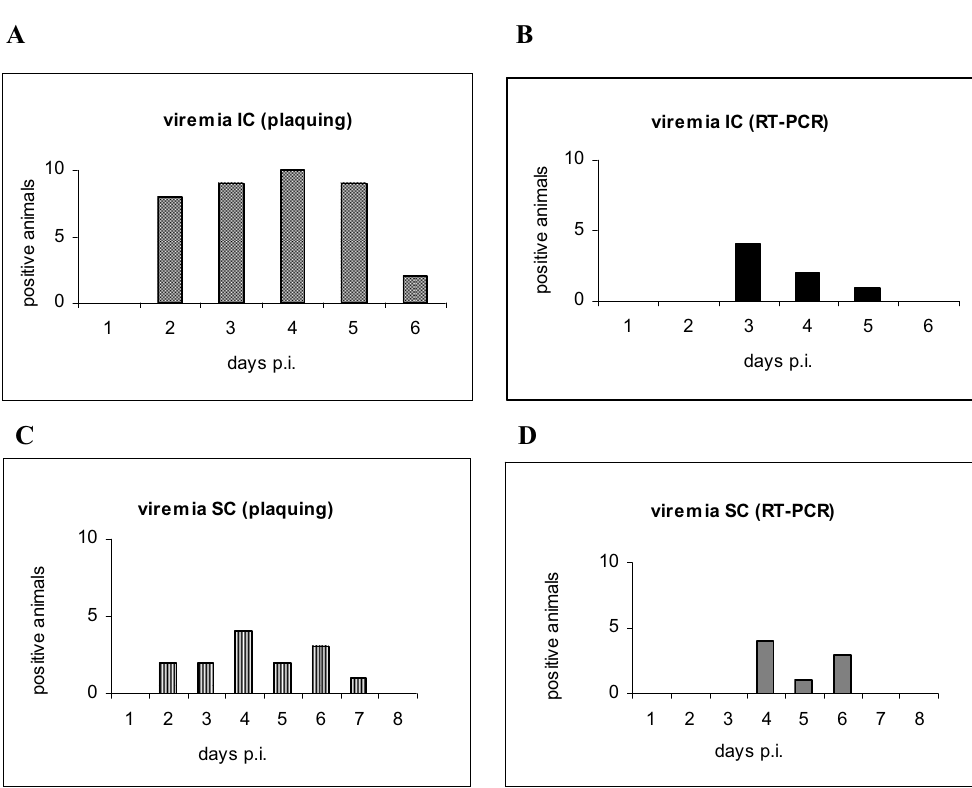
Fig. 2 – Detection of YFV 17DD virus inoculated by different routes. Intracerebral (Panels A and B); subcuta- neous (Panels C and D). Positive animals / days p.i., detected by plaque assay (Panels A and C) and by real time RT-PCR (Panels B and D).